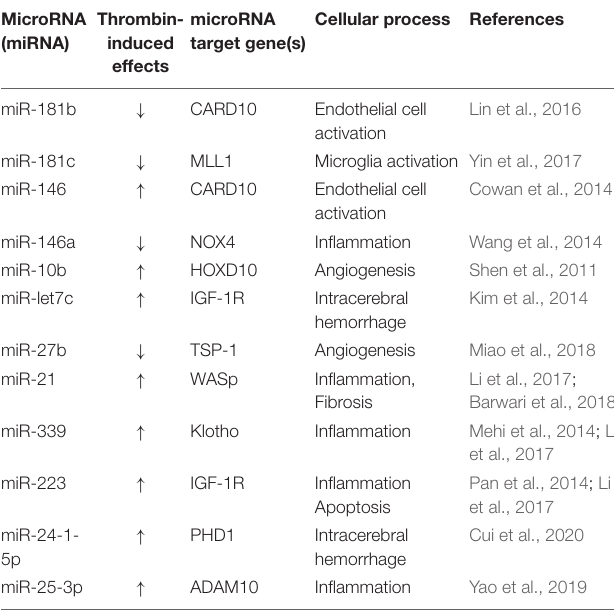
TABLE 1 | Thrombin effects on miRNA target genes and cellular